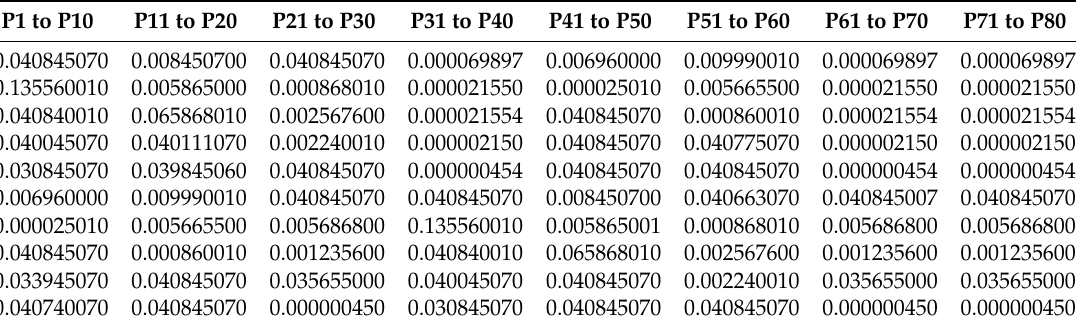
Table 2. ANP Weights ( t i ) of the workers (P1, P2, P3, . . . P80).